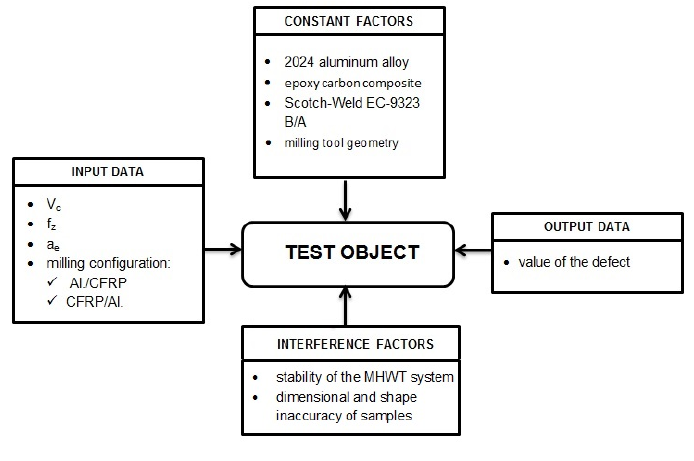
Figure 8. Research plan. Table 4. Research hypotheses and sets of critical values for Fisher-Snedecor test, Student’s t-test and Cochran-Cox test